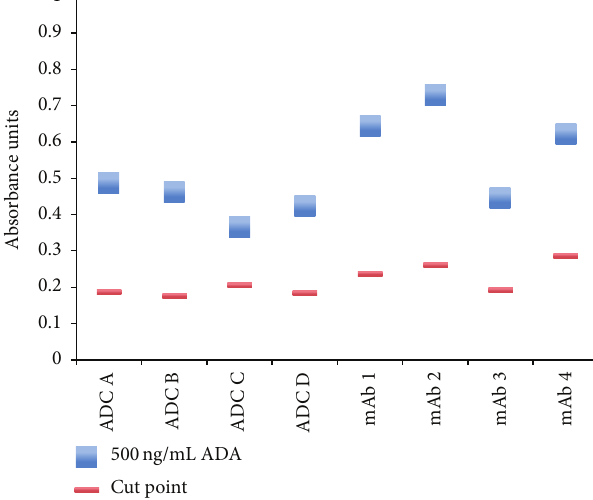
Figure 7: The plug-and-play assay showed adequate sensitivity for cynomolgus monkey studies across molecules. Pooled cynomolgus monkey serum was spiked with 5 𝜇 g/mL of eight biotherapeu- tics (baseline sample) or with the biotherapeutics (5 𝜇 g/mL) and 500 ng/mL of ADAs (purified cynomolgus monkey anti-human IgG). Cut points were calculated for each biotherapeutic from the signal at baseline and the generic cut point factor for a 5% false positive rate (CPF = 1.16). With all the biotherapeutics, the sample containing 500 ng/mL of ADA was positive with signals above their corresponding cut points. ADA = anti-drug antibody; ADC = antibody-drug conjugate; mAb = monoclonal